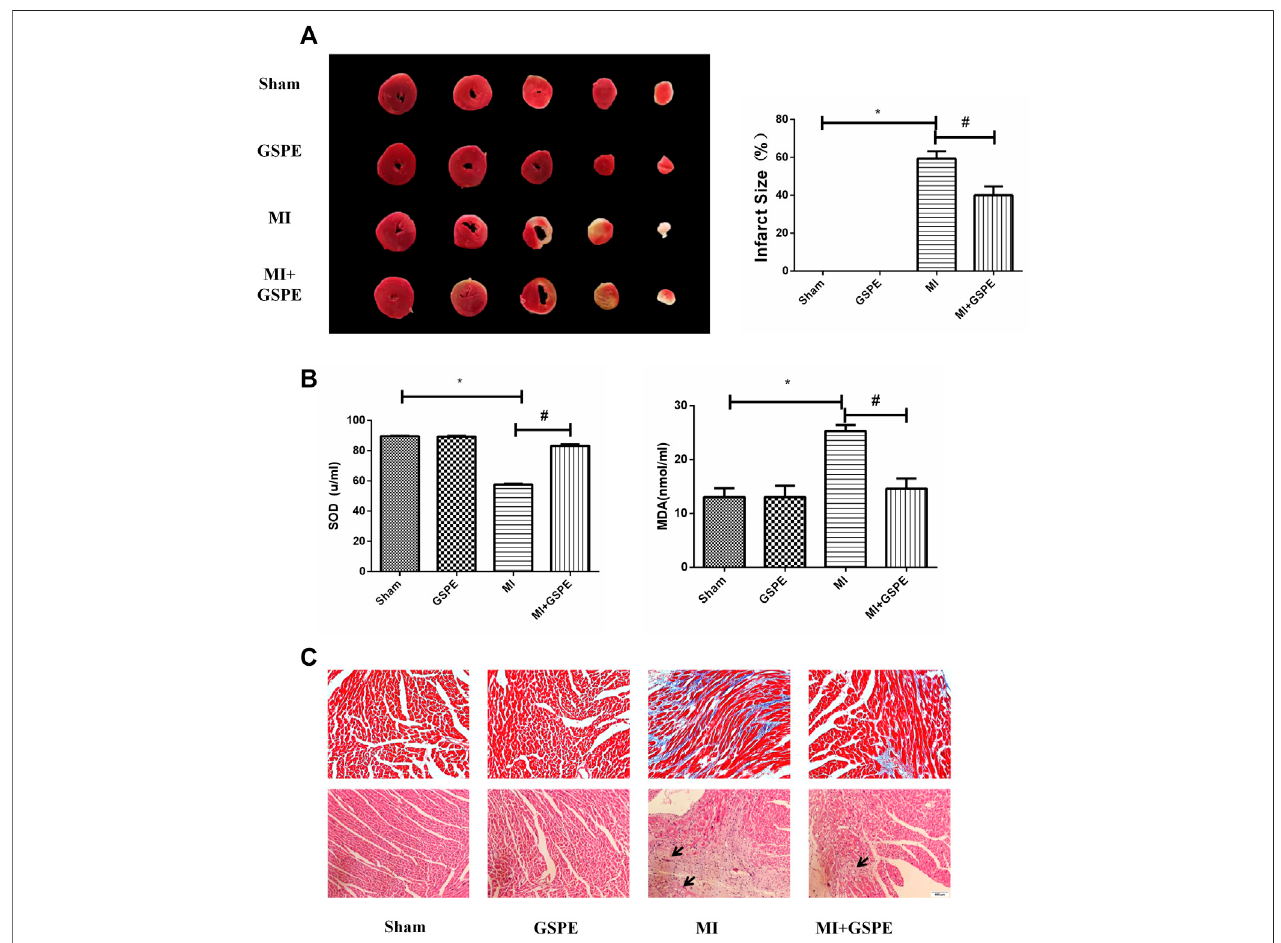
FIGURE2| GSPE improved the fi brosisinmyocardialtissue andmyocardialpathologicalchangesofMImice. (A) Representativeimage andanalysisofinfarct size byTTCstaining,normalareaisred,infarctareaiswhite. (B) ThecontentsofSODandMDAthemiceserumindifferentfroup. (C) PathologicalchangesinHE-staininganf Massonstainingofcardiacsection.Thein fl ammatorycellsinHEstaininghavebeenmarkedwitharrows.Dataanalyzedaremean ± SD.*Signi fi cantdifferencecompared with the control group, p < 0.05; #signi fi cant difference compared with the MI group, p < 0.05. n (cid:2) 3 per group.